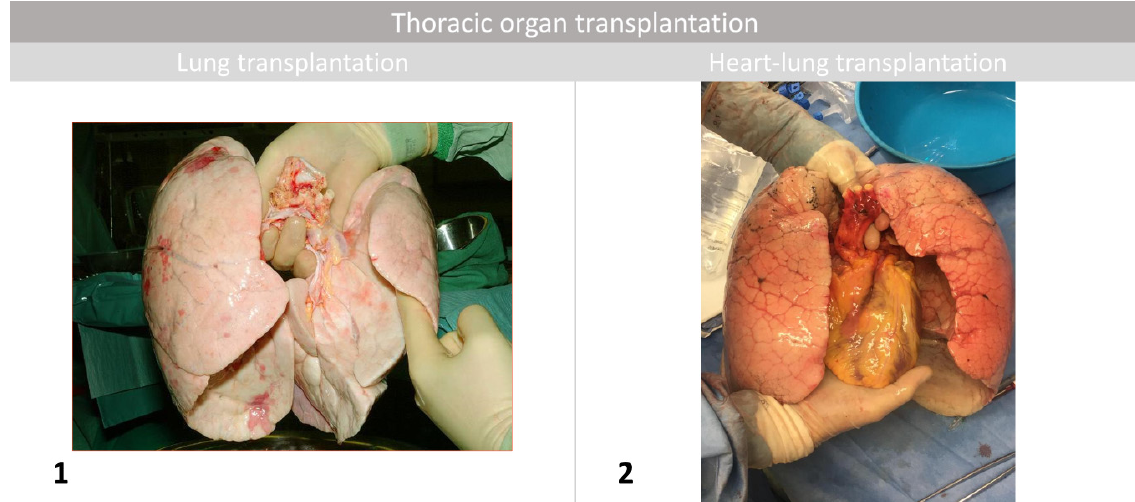
Figure 4. ( 1 ) Organ (double lung) for transplantation. ( 2 ) Organs en bloc (heart and lungs) for heart-lung transplantation.